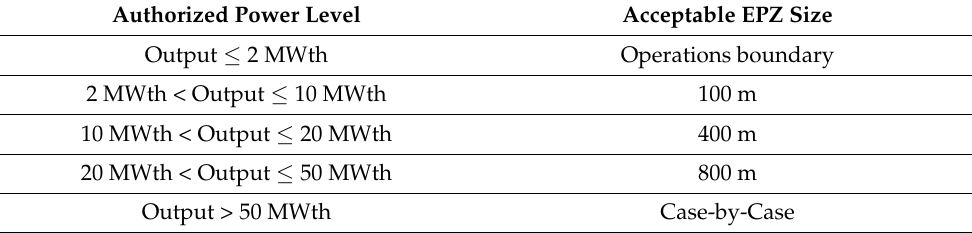
Table 4. EPZ size for